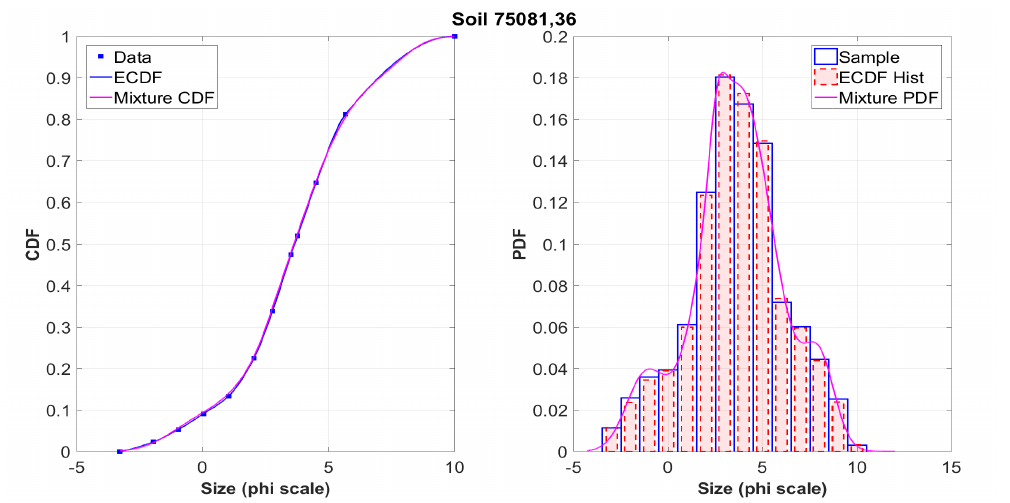
Figure A9. Soil 75081,36 (“Apollo